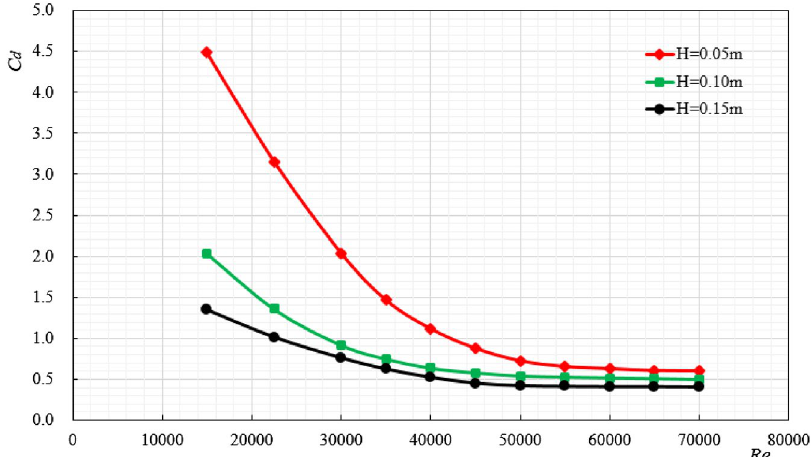
Figure 4. The variation law of resistance coefficient under different excitation displacements.